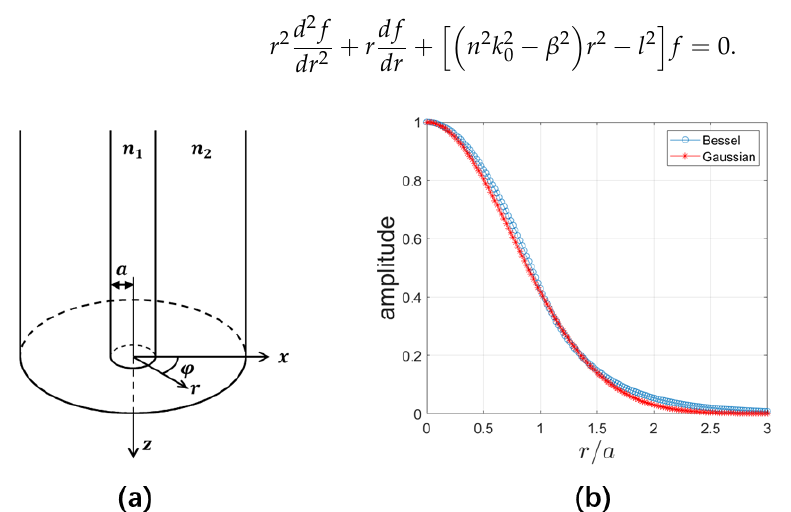
Figure 2. Structure of the optical fiber and its light mode. ( a ) A step-index fiber with n 1 and n 2 the index of refraction for the core and cladding. ( b ) The field amplitude of the Bessel mode in a single-mode fiber with a V number of 2.4, and its comparison with a Gaussian mode that has the same diameter where the field intensity drops to 1/ e 2 of the peak value. Both amplitudes are normalized to the maximum amplitude of the